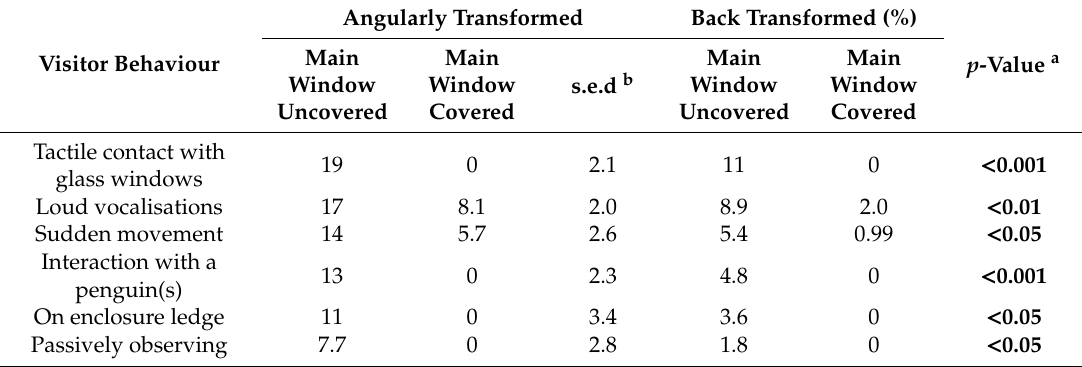
Table 4. E ff ects of treatment on the mean proportion of 60 s sample periods in which visitor behaviours occurred at the main visitor viewing area window (observed in six 30 min observations blocks: total of 180 sample periods each day). Data were angularly transformed. Any statistical significance ( p < 0.05) are bolded.